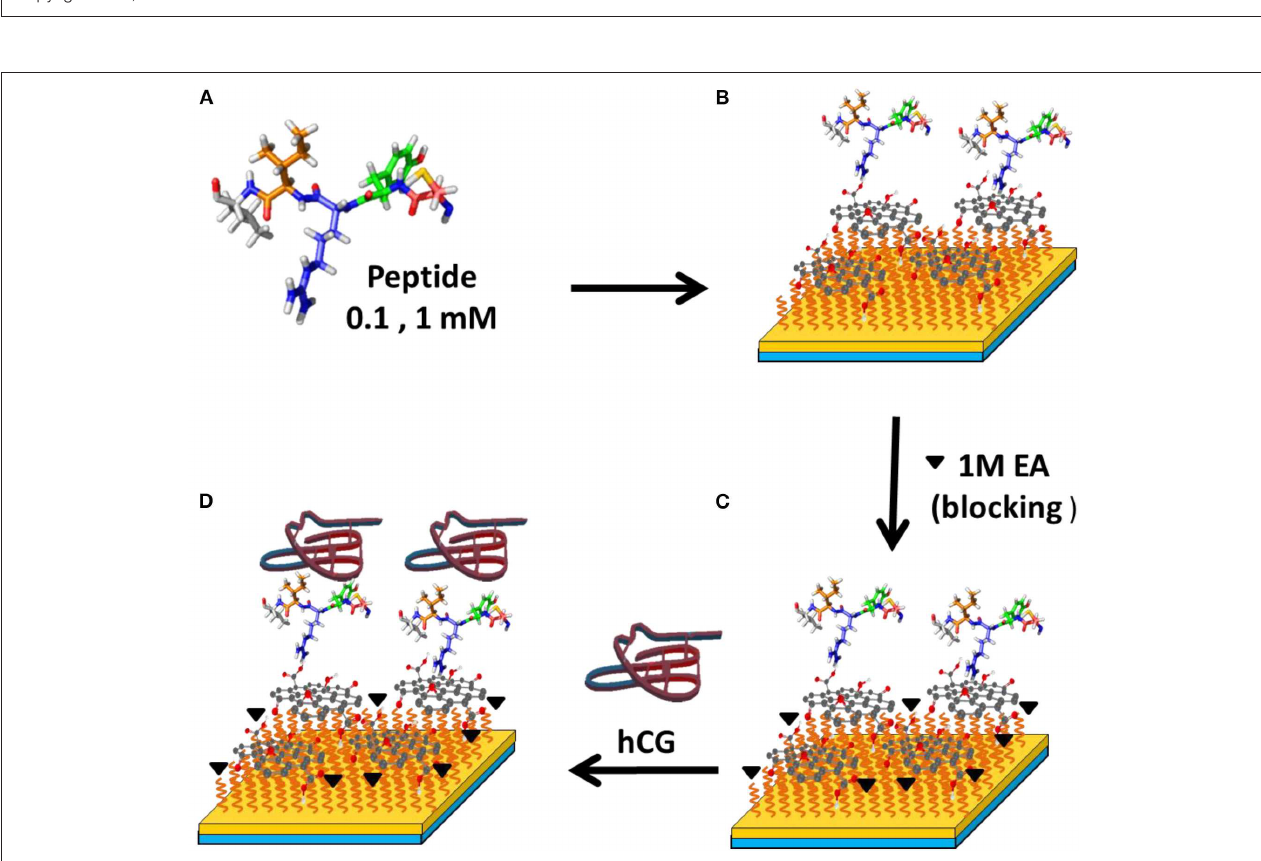
FIGURE 7 | Surface modification to detect hCG protein with SPR biosensor. Figures (A–D) were reproduced from Chiu et al. (2017b) with permission from Elsevier. Copyright 2017, Elsevier.